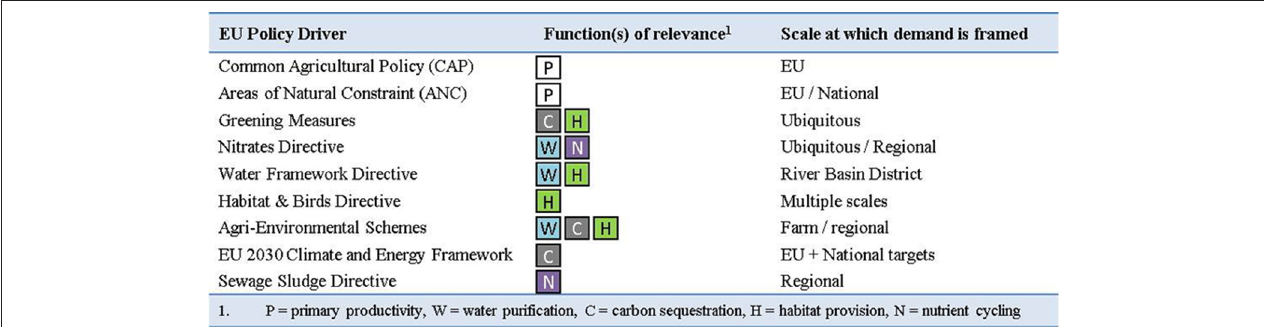
FIGURE 3 | Inventory of EU policy drivers that frame the demand for the five soil functions (illustrated by the colored boxes), and the spatial scale to which each of these policies applies.